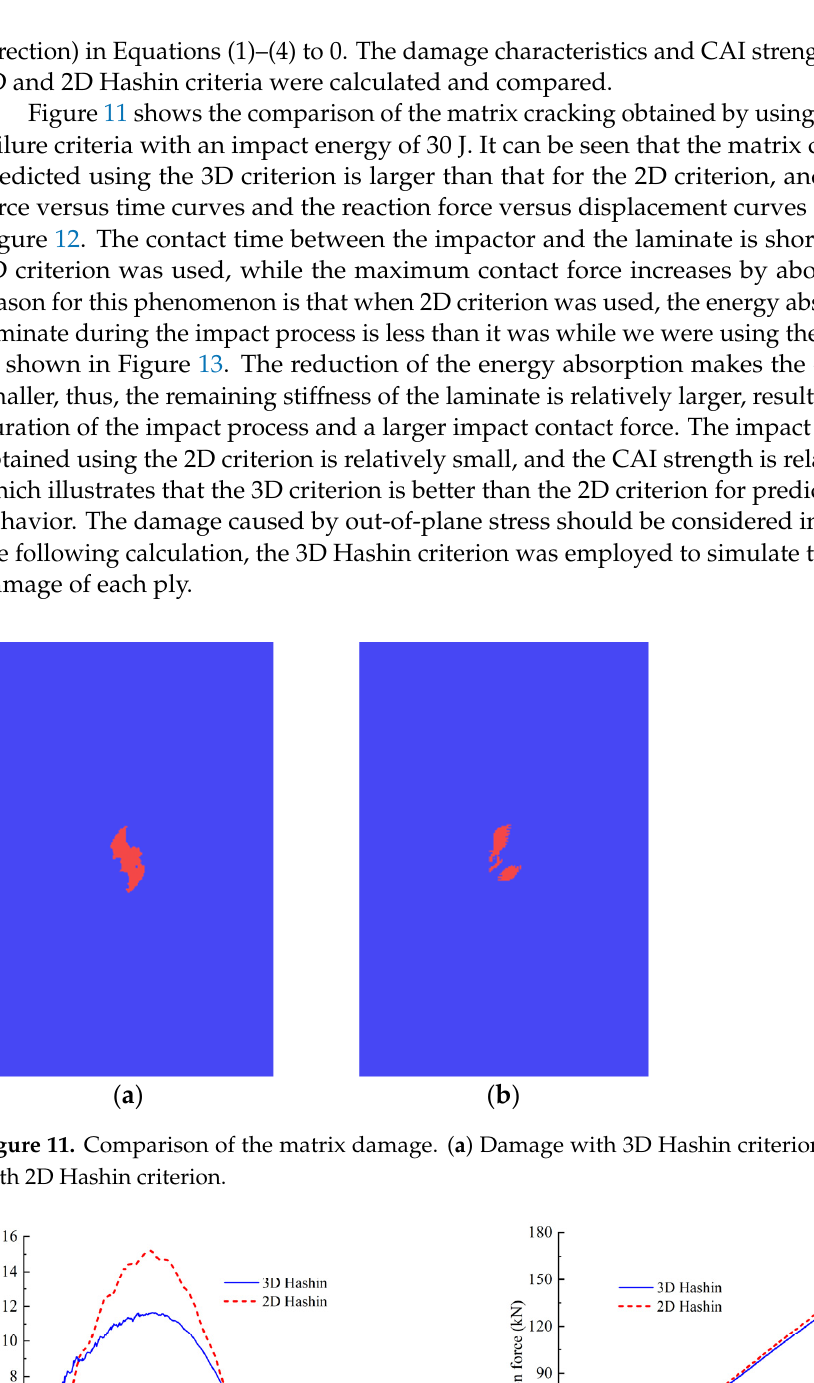
Figure 13. Kinetic energy variation of the impactor.